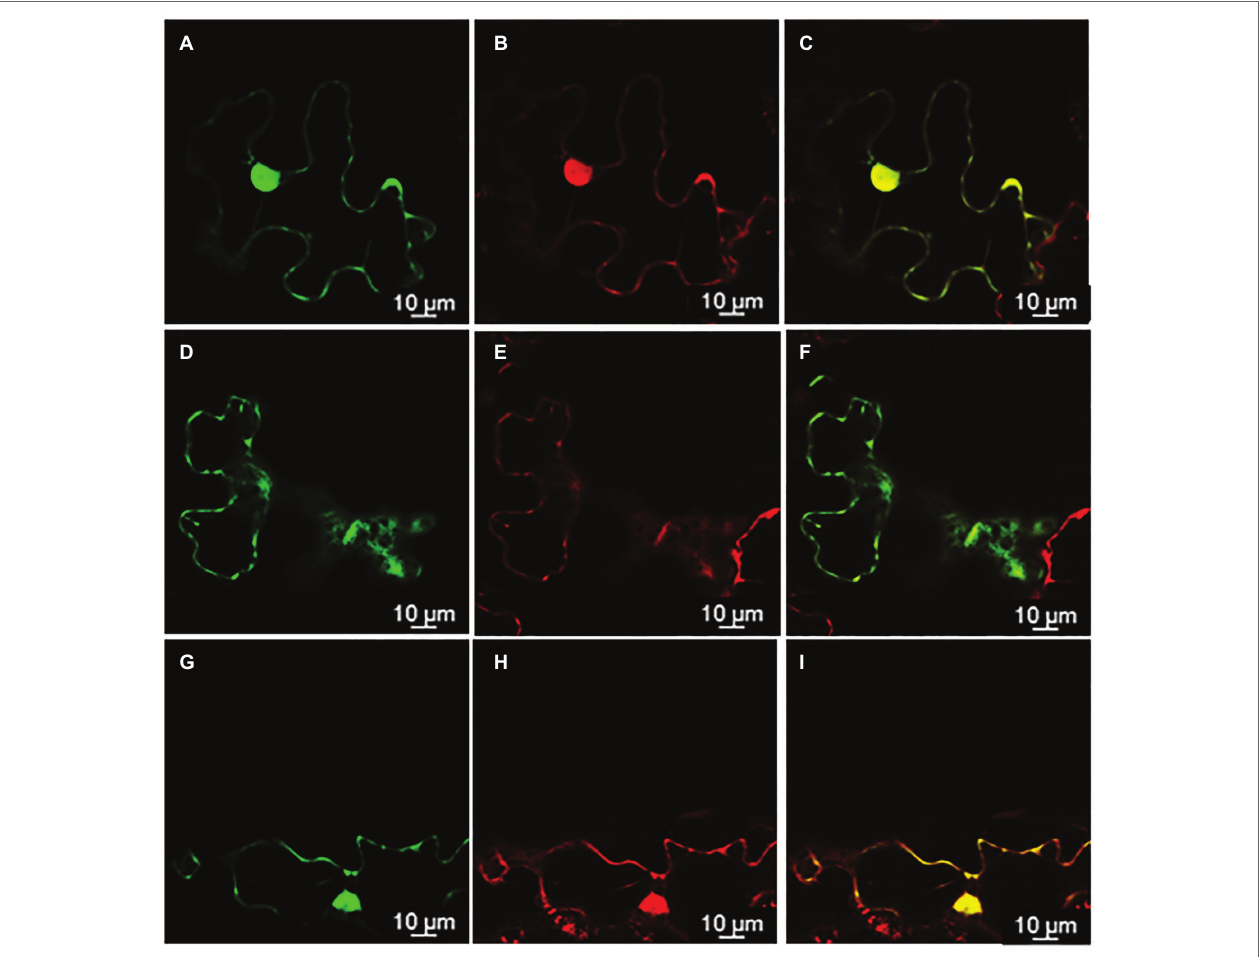
FIGURE 6 | Δ ORF13a localization in the cytoplasm visualized by confocal microscopy of Nicotiana benthamiana epidermal leaves. (A) Δ ORF13a fused to enhanced Green Fluorescent Protein (eGFP) on its C-terminal end permeates through the nuclear pores and can be found inside the nucleus (B) as confirmed by soluble monomeric Red Fluorescent Protein1 (mRFP1) control, panel (C) is an overlay of signals from Δ ORF13a-eGFP and mRFP1 demonstrating complete co- localization of both proteins. (D) Soluble proteins fill out the cytoplasm around the cortical endoplasmic reticulum (ER) as observed for Δ ORF13a-eGFP and (E) mRFP1, panel (F) is an overlay of signals from Δ ORF13a-eGFP and mRFP1 demonstrating complete co-localization of both proteins. (G–I) Fusion of eGFP to the N-terminal end of Δ ORF13a did not affect the localization of Δ